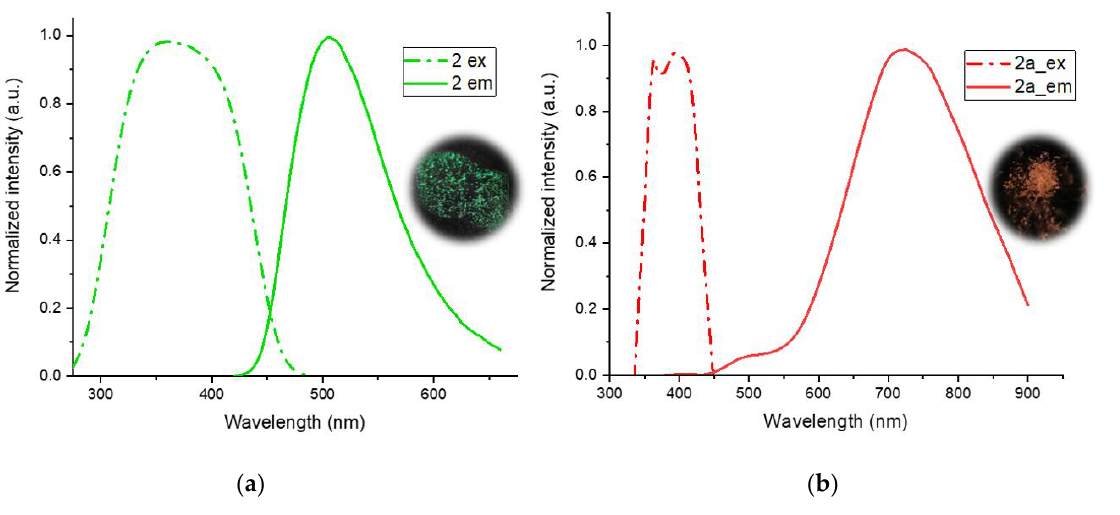
Figure 4. Solid-state excitation (dash-dot) and the emission (solid) spectra of polymer 2 ( a ) and solid phase 2a ; ( b ) powders of polymer 2 and solid phase 2a under UV-light irradiation (365 nm). The heating up of the coordination polymer 2 to 138.5 °C leads to a change in the color of the sample emission to red, with the maximum at 725 nm in the emission spectra, although the cooling-down of the sample to room temperature does not mark a return to green emission conditions. Thus, the heating up of sample 2 leads to the solid-state transformation of the polymer to the solid phase 2a , which was confirmed by differential scanning calorimetry (DSC) (Figure 5).